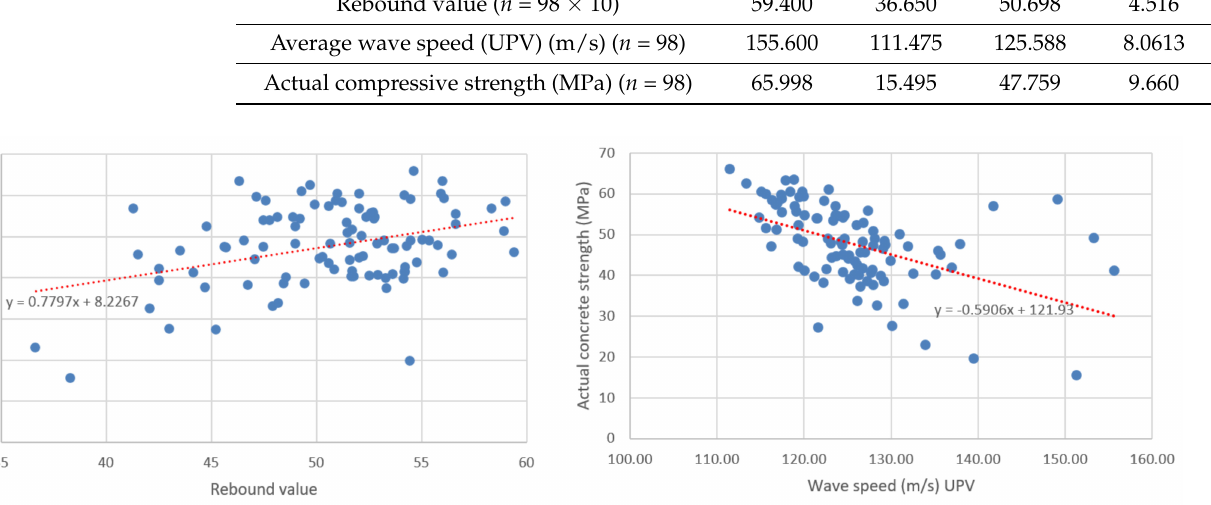
Figure 1. Actual concrete strength linear fit